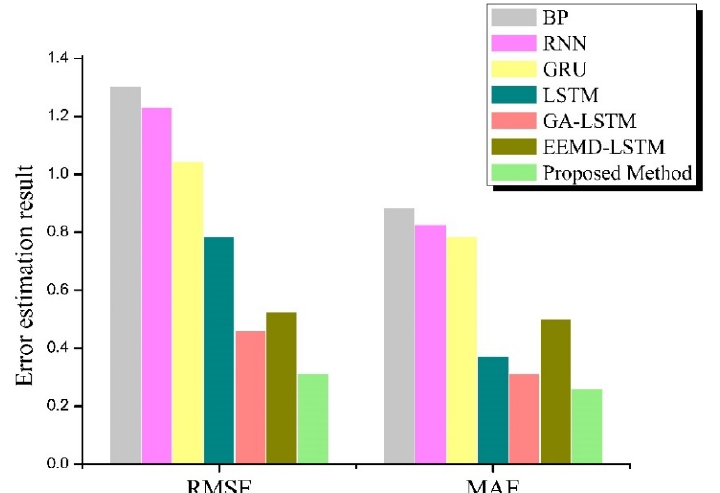
Figure 12. Error estimation result of propagation-loss prediction methods (surface duct).